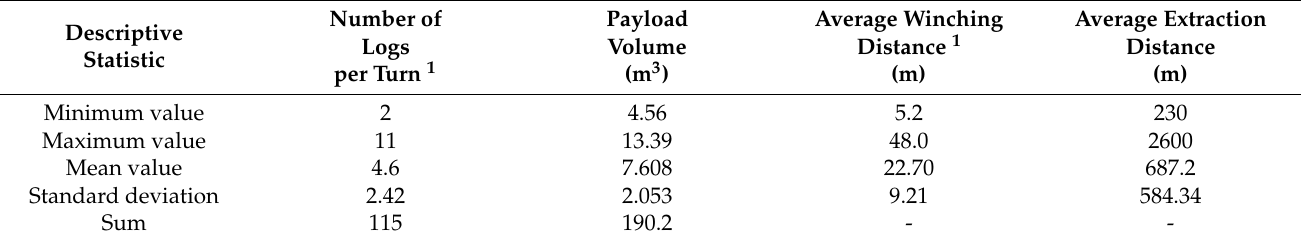
Table 2. Statistics of operational variables.